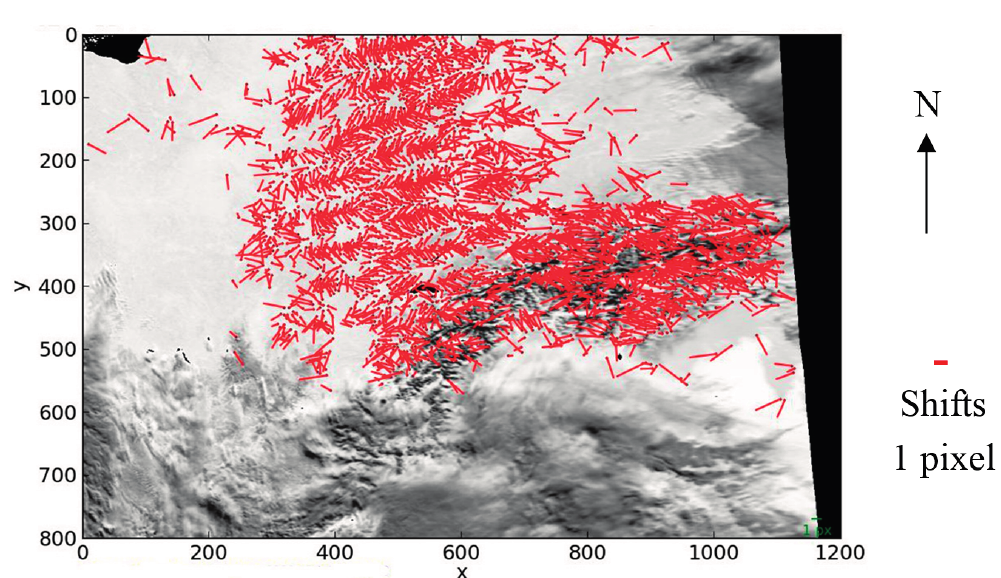
Figure 11. Image space shifts obtained from matching of two NOAA-18 images acquired on 26 December 2008. The axes denote the image coordinates.